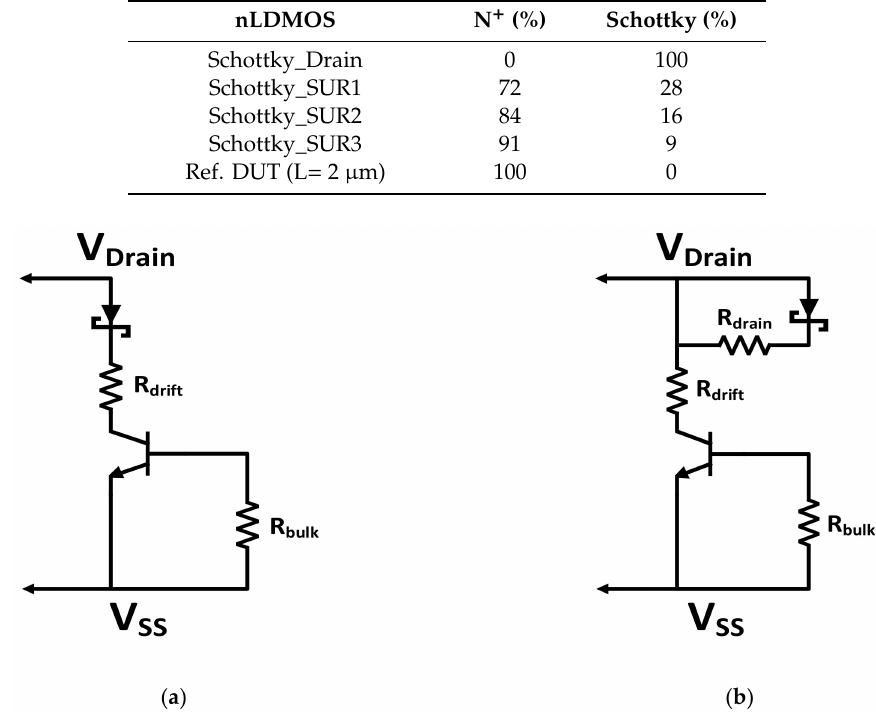
Figure 8. Parasitic equivalent circuits of an HV nLDMOS with drain-side ( a ) full removing N + heavy doping, and ( b ) a central-type embedded Schottky diode modulation in the drain